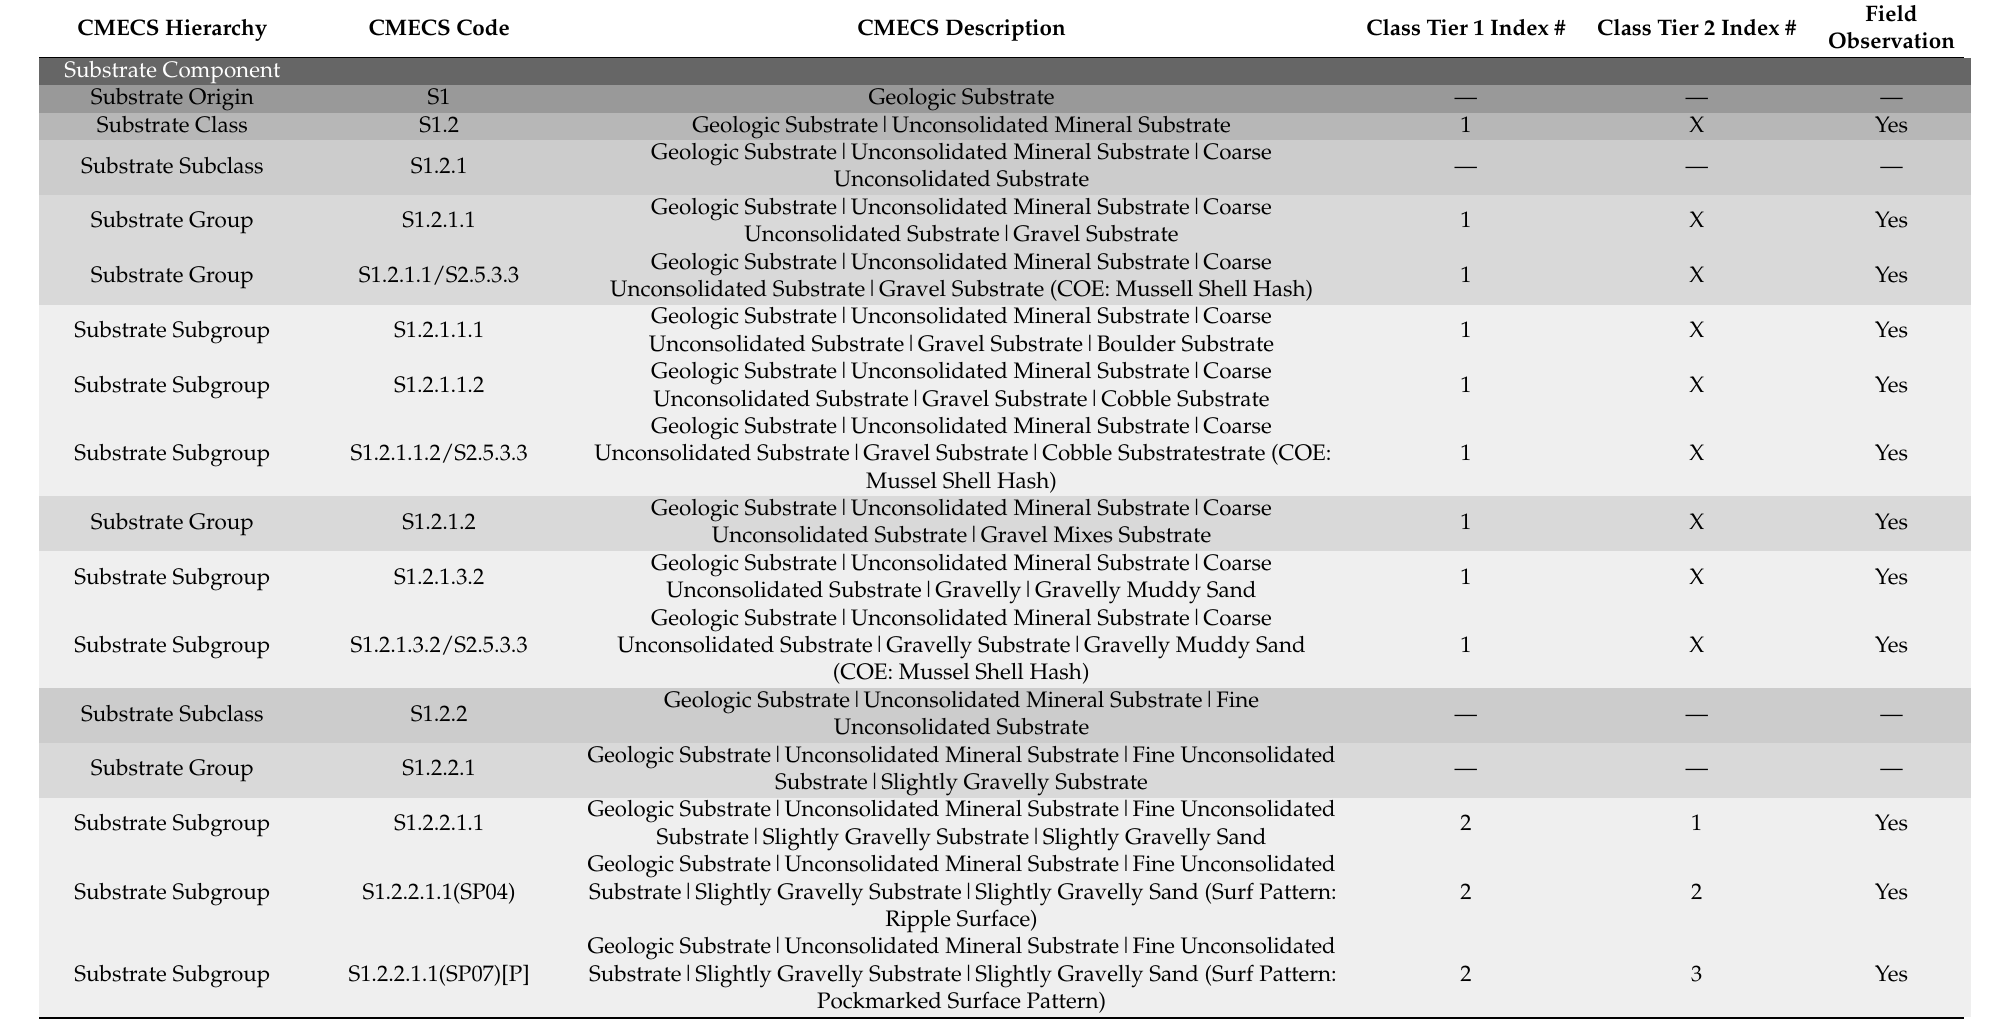
Table 1. CMECS components, units, descriptions, classification tier, corresponding class value (identified by class tier index number), and classes with corresponding field observations used in this study. Class tier index numbers correspond to short class names in Tables 2 and 3 (# =